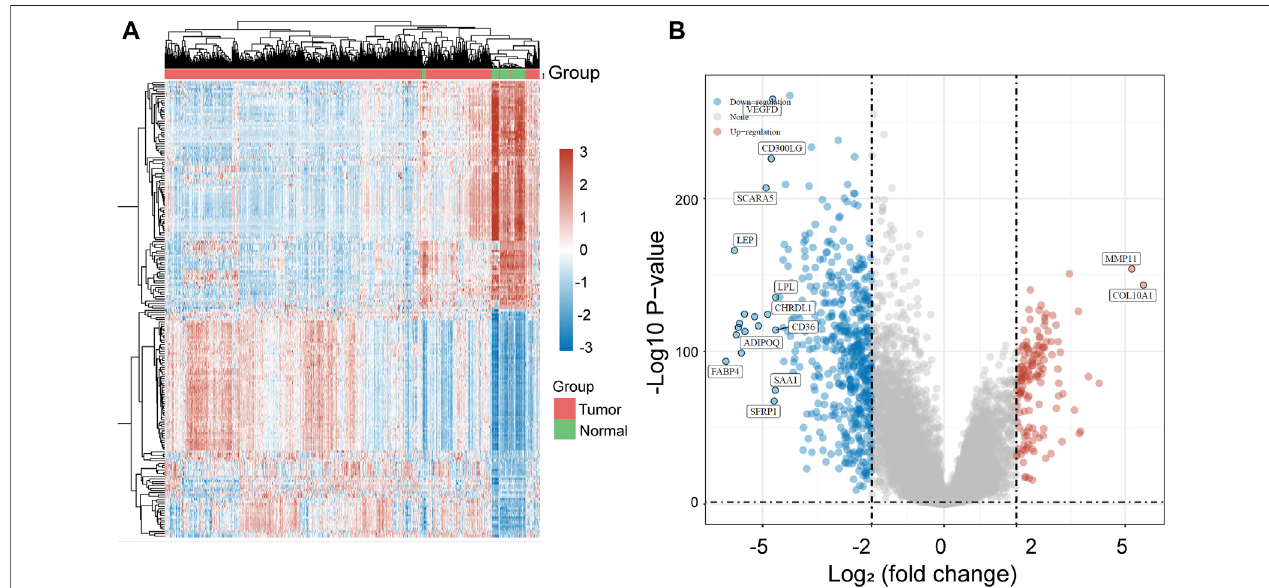
FIGURE 1 | The identi fi cation of DGEs in BC based on TCGA datasets. (A) Heat map of all DGEs between BC specimens and normal breast specimens. (B) Volcanic map of DGEs based on the standard of FC >